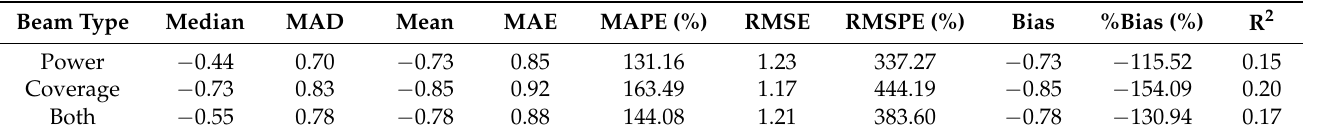
Figure 7. Scatter of total PAI for all sample ALS and GEDI footprints in the study area. The 1:1 line is shown in red; the color of the pixel (legend) represents the number of footprints having a common value of plant area index (PAI). Table 6. Overall accuracy of GEDI PAI estimates for all individual footprints (11,832). Statistics for differences in values (ALS PAI , GEDI PAI